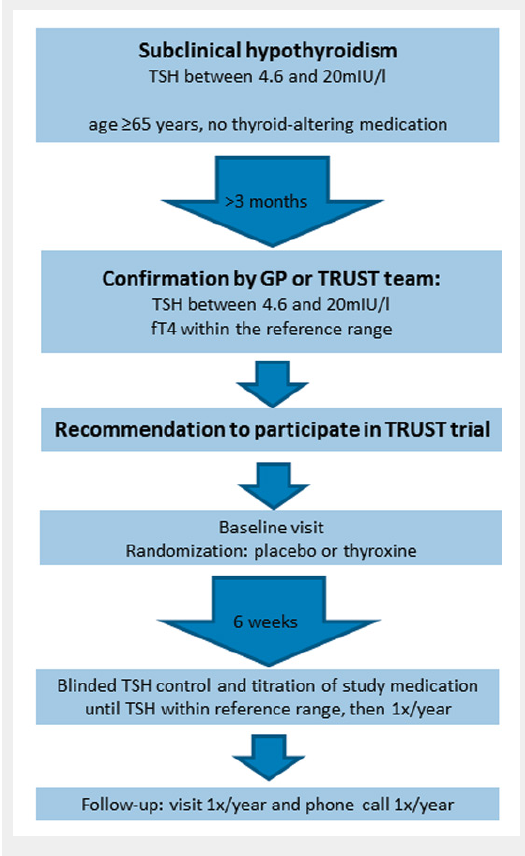
TRUST trial. Process for inclusion in the TRUST trial: Confirmation of subclinical hypothyroidism and patient visits during the course of the trial. See chapter “Conclusion and perspectives: The TRUST trial” for more details. Figure: adapted according to [59]. fT4 = free thyroxine; GP = general practitioner; TSH = thyroid- stimulating